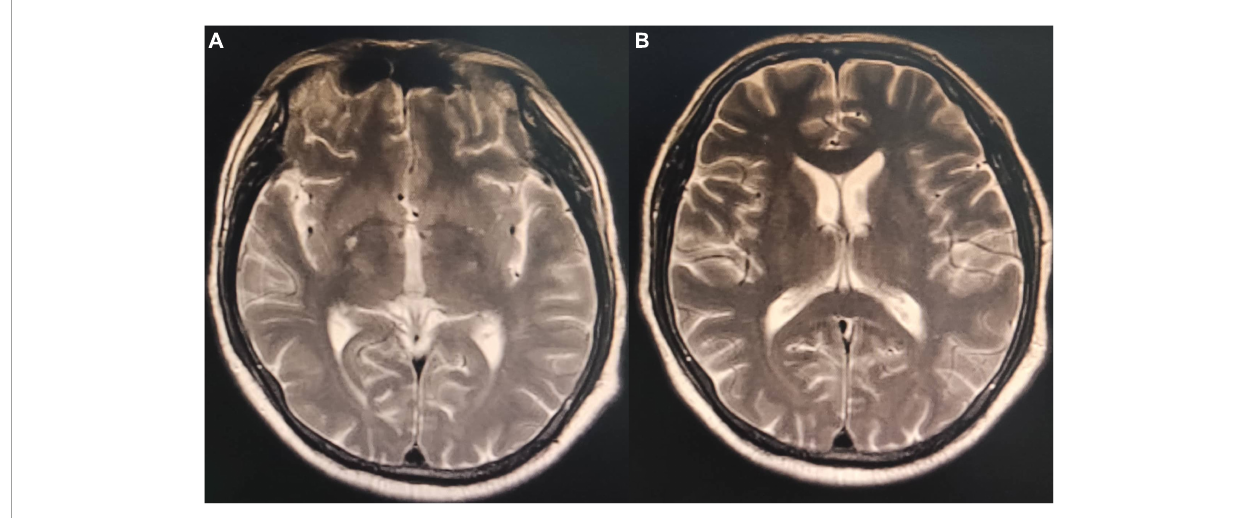
FIGURE3 Magnetic resonance imaging T2 phase of the patient’s brain. (A) Small patches of the long T2 signal shadow in the right basal ganglia with hyperintensity in T2 fluid-attenuated inversion recovery (FLAIR) and a few patchy long T2 signals in the white matter of bilateral cerebral hemispheres with hyperintensity in T2 FLAIR. Acute lacunar infarction in the right basal ganglia might be large, and there were few ischemic degeneration foci in the white matter of the bilateral cerebral hemispheres. (B) Small patches of long T2 signal shadow were observed in the right basal ganglia, with slight hyperintensity in T2 FLAIR. A few patchy long T2 signals were observed in the white matter of the bilateral cerebral hemispheres, with hyperintensity in T2 FLAIR. A few ischemic degeneration foci in the white matter of bilateral cerebral hemispheres and ischemic infarction foci in the right basal ganglia were